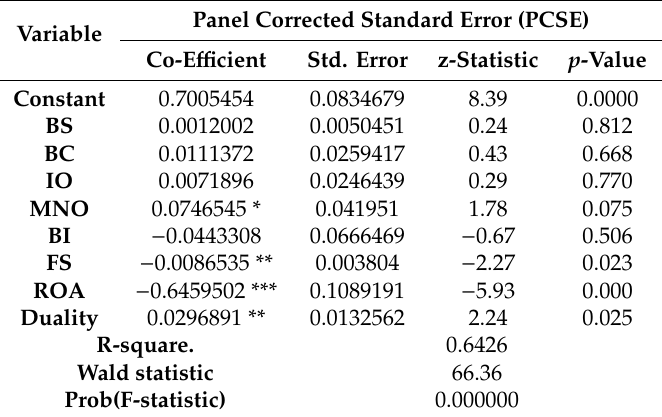
Table 5. Estimated Results of Panel Corrected Standard Error